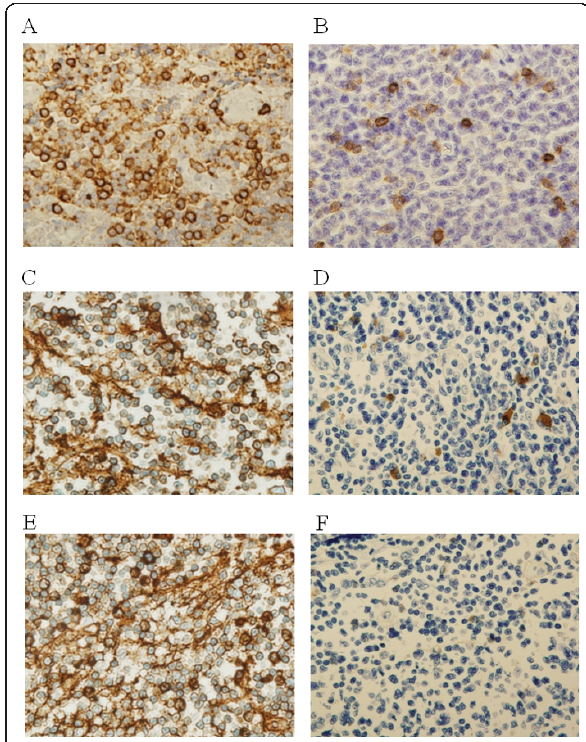
Figure 3 Immunohistochemical comparison of CD5, lambda, and kappa expression in primary and recurrent buccal MALT lymphomas (magnification ×630) . Immunohistochemical staining of primary tumor sections show that the tumor cells are positive for CD5 (A), kappa (C), and lambda (E). Immunohistochemical staining of recurrent tumor sections show that the tumor cells are weakly positive for CD5 (B) and kappa (D) and negative for lambda